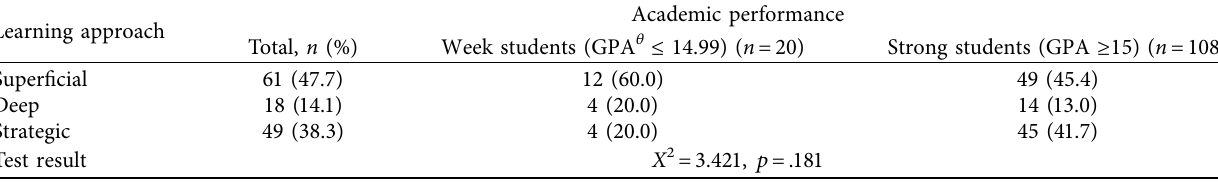
Table 2: The relationship between learning approaches and academic performance in strong and weak students. Learning approach